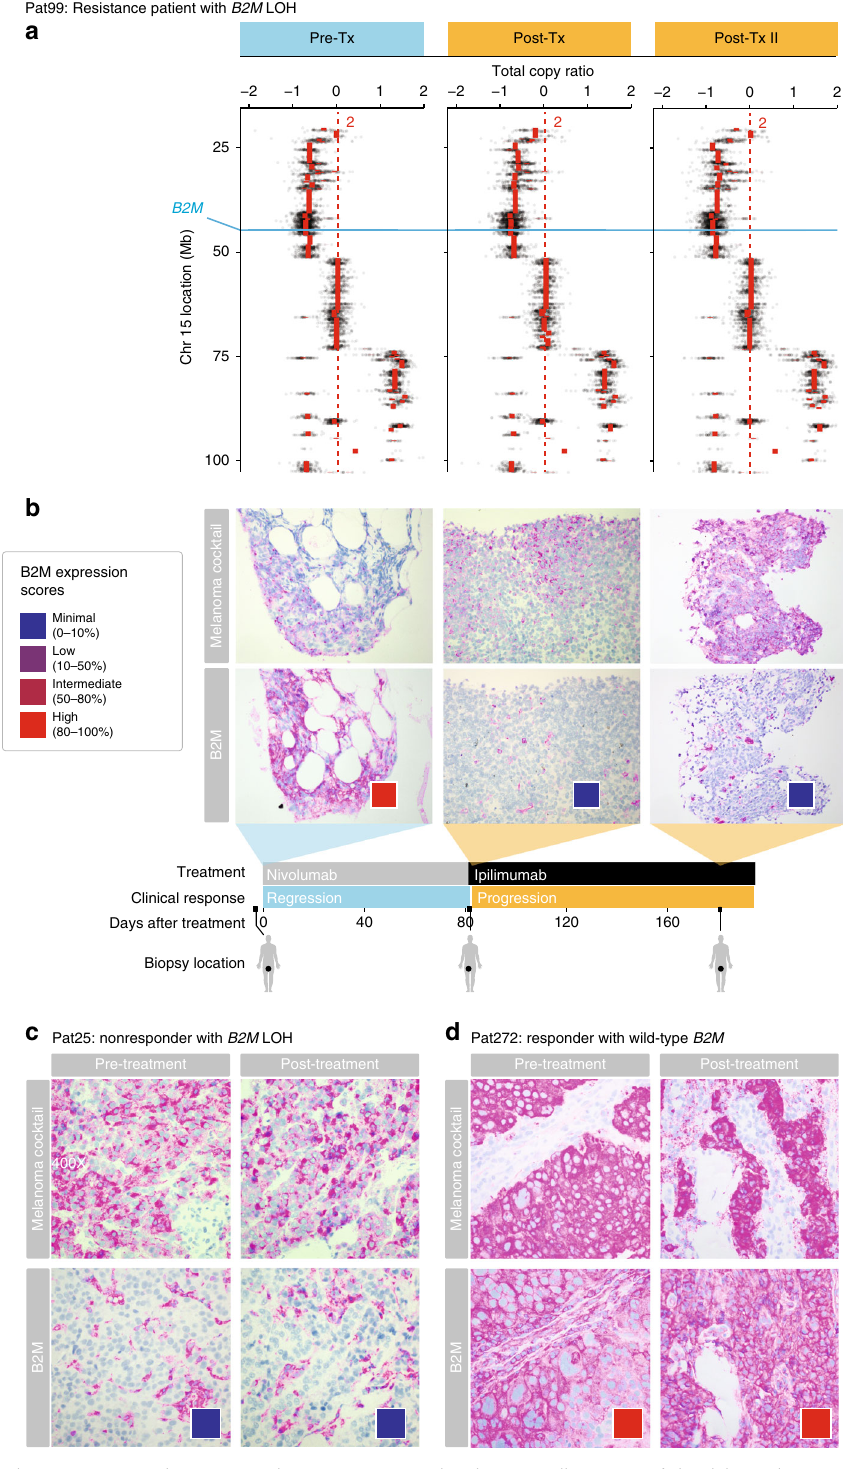
Fig. 3 LOH in B2M is found in resistance and non-responding patients treated with CPB. a Illustration of the deletion locations on chromosome 15 overlapping the B2M locus found in Pat99 (blue line); and the total copy ratios of target regions on chromosome 15 in each biopsy. Red dashed lines indicate an absolute total copy number of 2 as inferred by ABSOLUTE. A deleted region overlapping the B2M locus is seen in all samples. Top row indicates the timeline of treatment (blue – regression, orange – progression). b – d Samples from Pat99 ( b ), Pat25 ( c ), and Pat272 ( d ) were stained with an antibody cocktail for melanoma cells (mel.cocktail) using anti-melanosome (HMB45), anti-MART-1/melan A and anti-Tyrosinase, to discern melanoma cells from normal cells; or with an antibody speci fi c for B2M. Colored boxes indicate B2M expression scores: B2M scoring was estimated by using four different levels of expression in the tumor fraction: minimal, 0 – 10%; low, 10 – 50%; intermediate, 50 – 80%; and high, 80 – 100%, B2M expression in the tumor fraction. Original magni fi cation